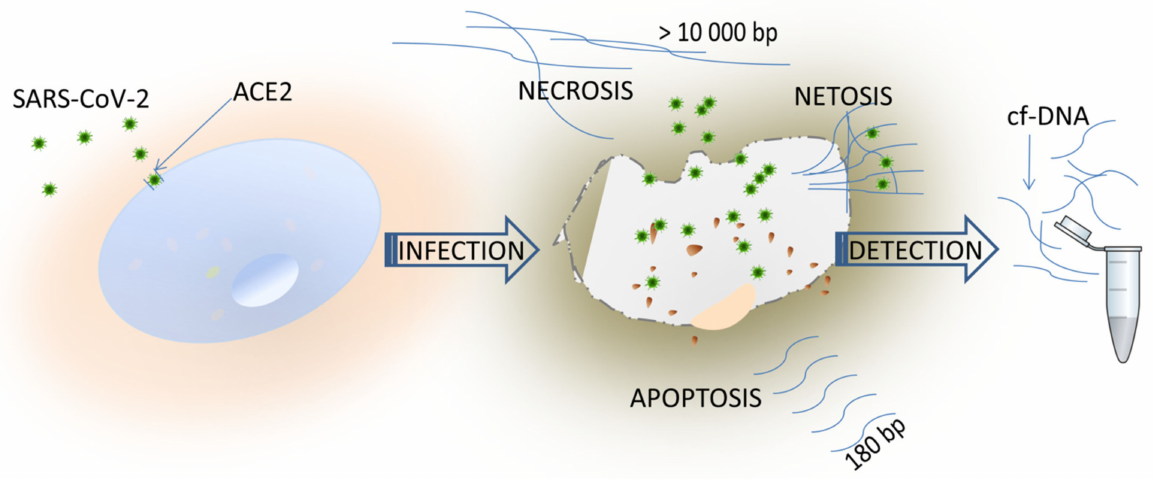
Figure 1. ACE2 as the entry receptor for SARS-CoV-2 and possible sources of cfDNA during COVID-19